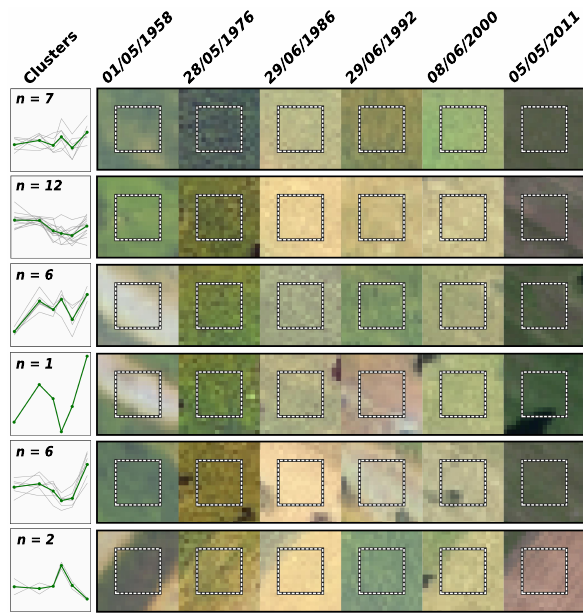
Figure 7. Clusters of trajectories obtained from the GCC on corrected products. In green, the average profile for the cluster. In gray, the individual trajectories for the grasslands. Each square corresponds to one of the 10 × 10 m quadrats that were used for sampling. Background images correspond to the colorized aerial